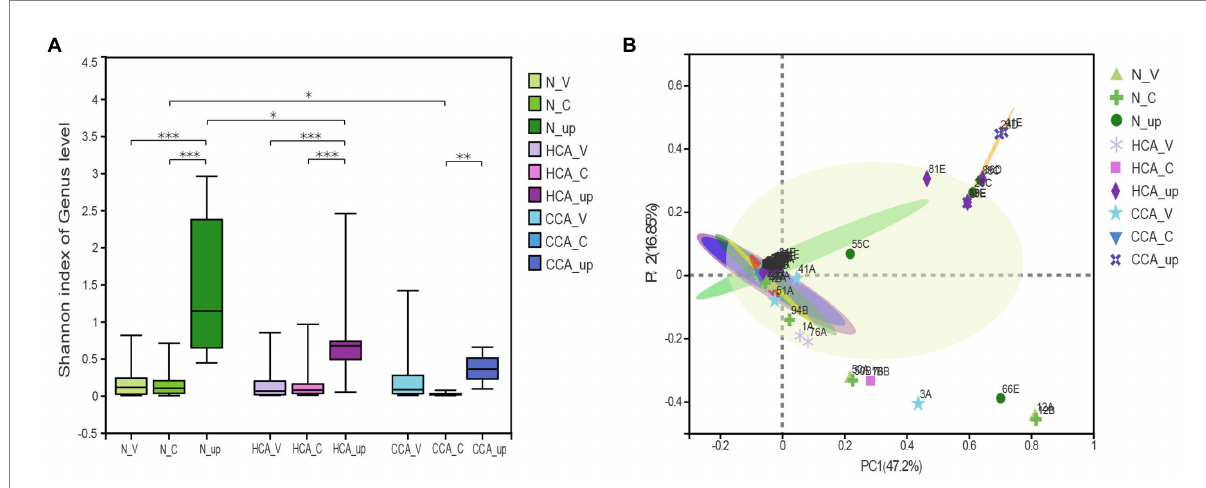
FIGURE 2 The diversity of the upper and lower genital tract microbiome were sequenced using 16S rRNA. (A) Alpha diversity was calculated using the Shannon diversity index in N, HCA, and CCA groups. (B) Beta-diversity was visualized using Principal Coordinate analysis (PCoA). The first two principal coordinate axes, which together explain 64.05% of variation, are shown. (*0.01 ≤ p < 0.05; **0.001 ≤ p < 0.01; ***0.0001 ≤ p <